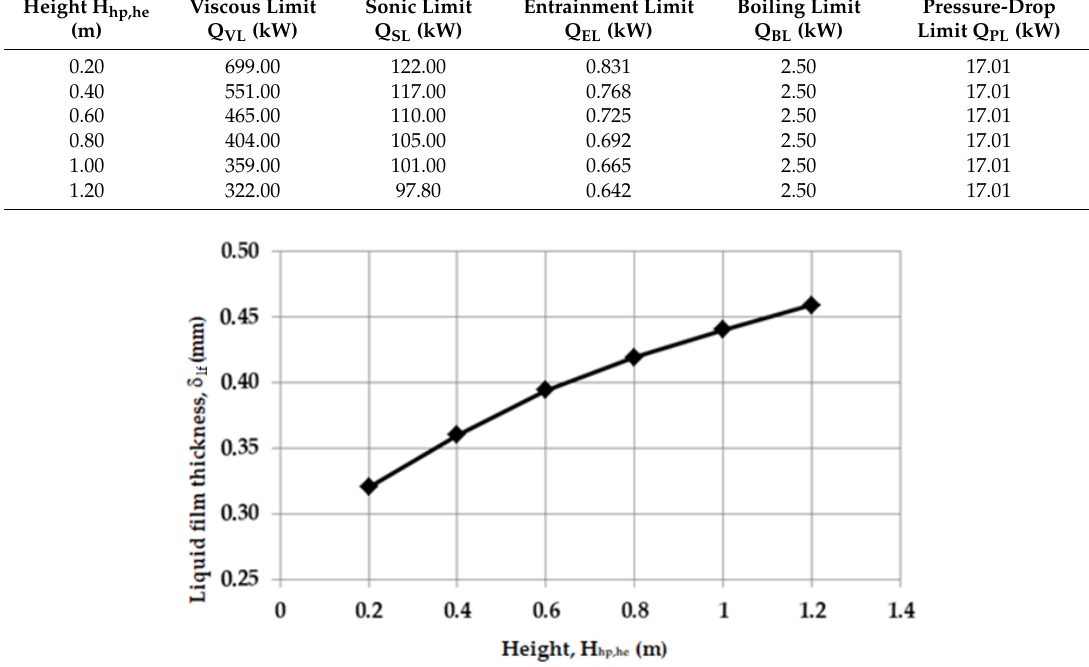
Table 4. Impact of the condenser-to-absorber height difference.